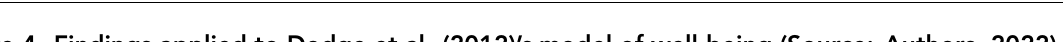
Figure 4. Findings applied to Dodge et al. (2012)’s model of well-being (Source: Authors,